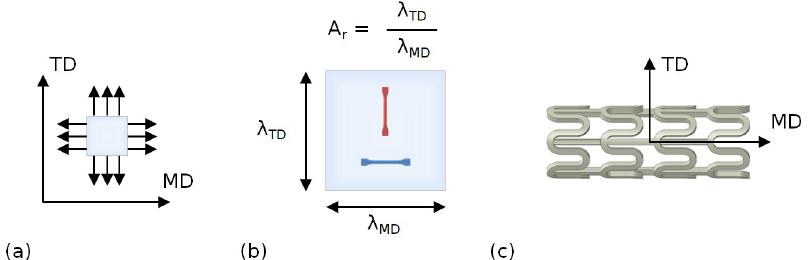
Fig 1. Schematic diagram showing (a) the biaxial stretching process in the machine direction ( MD ) and transverse direction ( TD ); (b) the definition of aspect ratio ( A r ), defined as the quotient of the stretch ratio in the TD ( λ TD ) ) and; (c) the alignment of the MD and the TD with a stent’s axial and and and the stretch ratio in the MD ( λ MD circumferential axes,